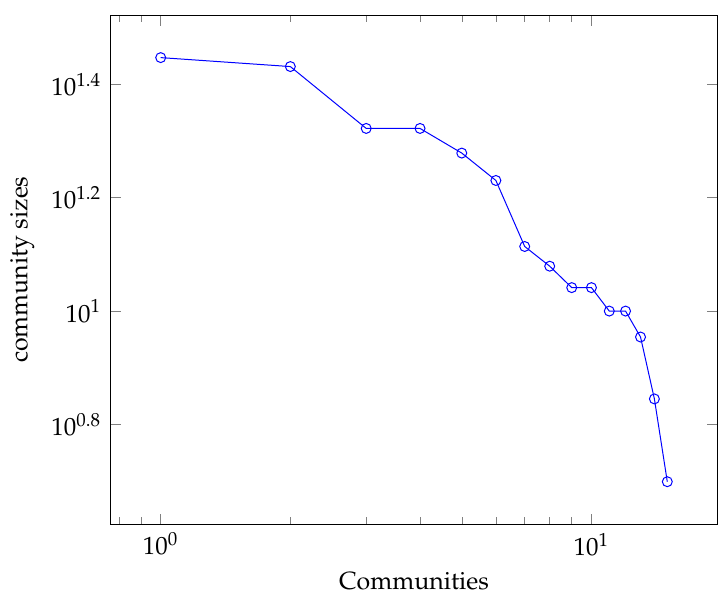
Figure 4. Distribution of community sizes in power law